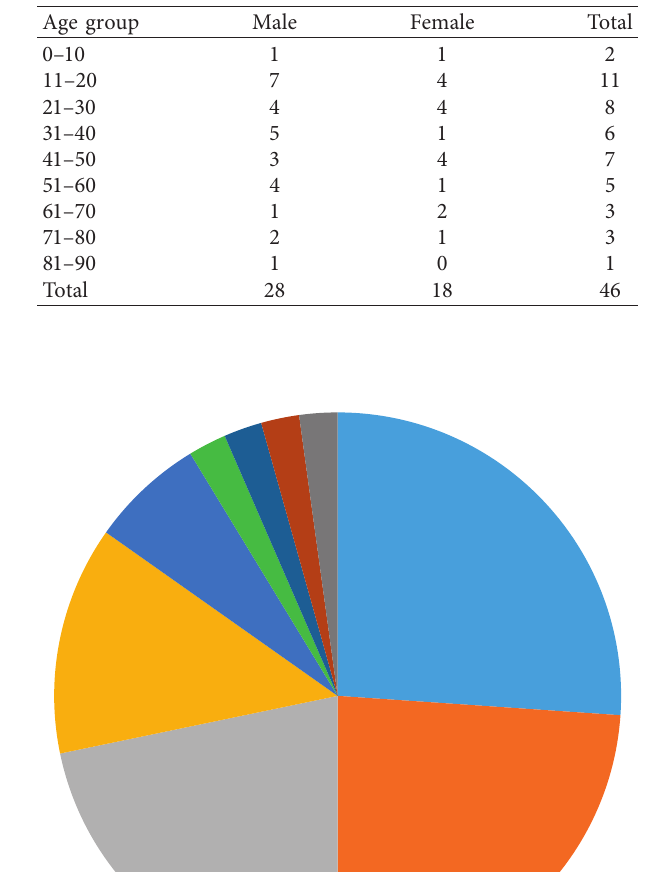
Table 1: The distribution of psoriatic patients with fungal infec- tions in different age categories.